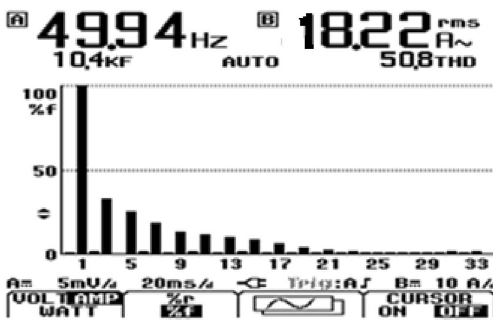
Fig. 8 Current harmonic orders by fluke